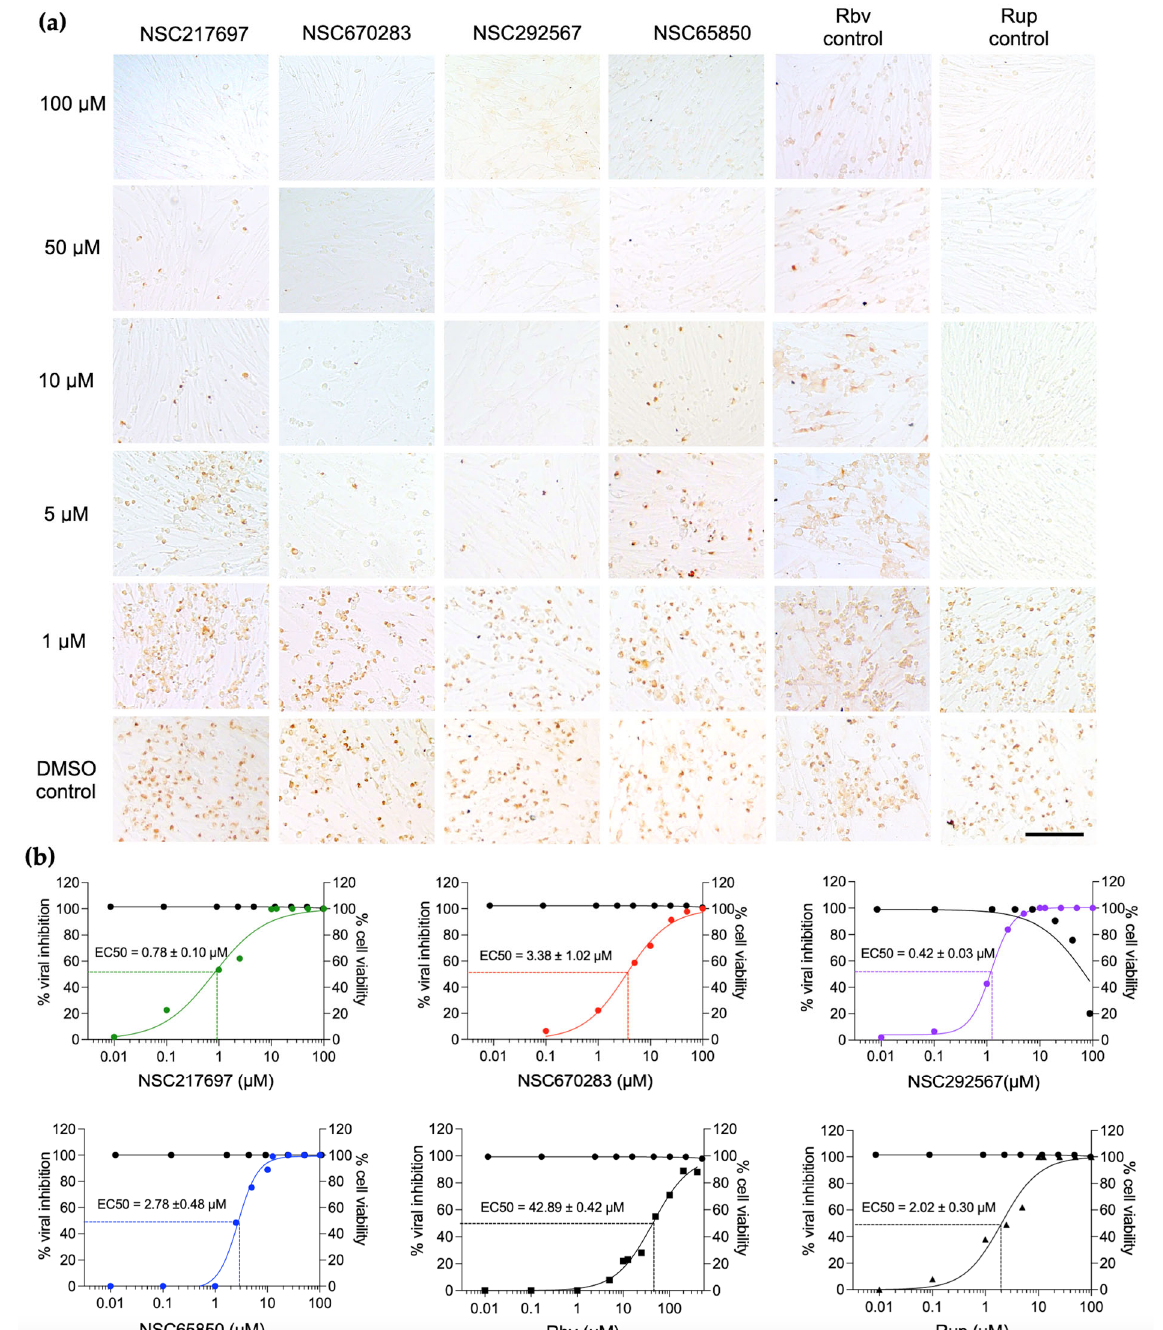
Figure 2. Antiviral activities of the selected compounds against FMDV in cell culture. Four small compounds were evaluated in a dose–response manner, and ribavirin (Rbv) and rupintrivir (Rup) were used as drug controls. The FMDV-infected cells with or without compound treatment were determined using IPMA in which viral antigens in the positive cells were stained with DAB and turned brown ( a ). Graphs of cytotoxicity and antiviral activities of the compounds demonstrating percentage of viable cells (black lines) and percentage of viral inhibition (color lines) at different concentrations of the compounds ( b ). The scale bar is 100 µm. Table 2. The cell-based antiviral activity against FMDV infection and cytotoxicity of compounds in BHK-21 cells.